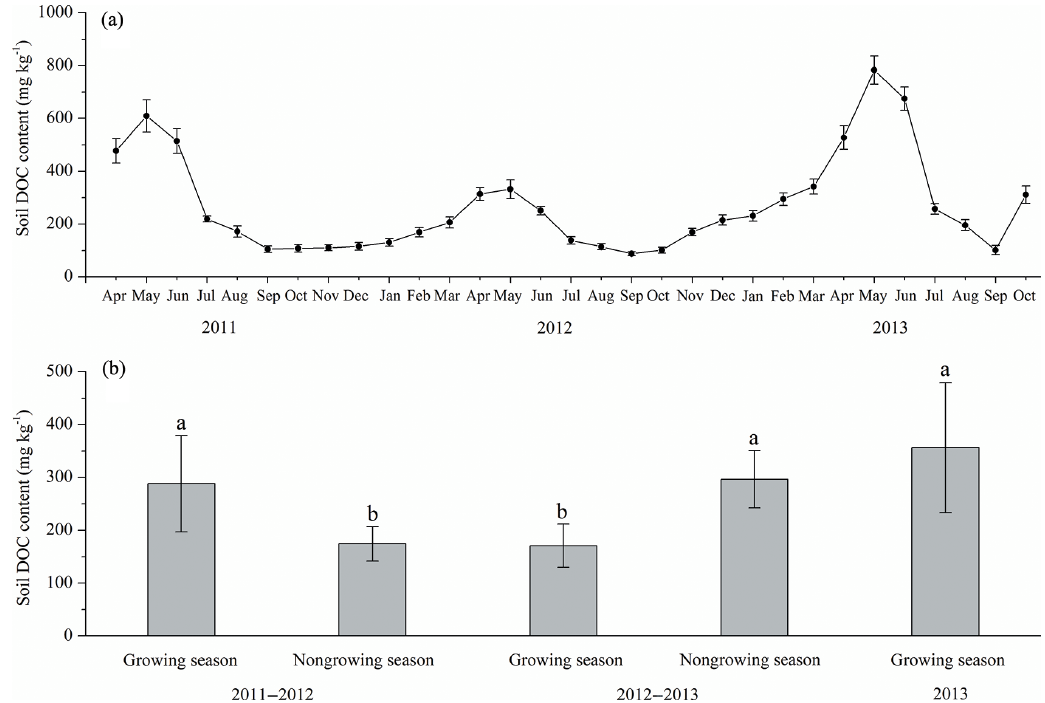
Figure 6. Dynamics of dissolved organic C ( a ; mean ± SE; n = 15) and its seasonal and interannual differences ( b ; mean ± SE; n = 90) from 2011 to